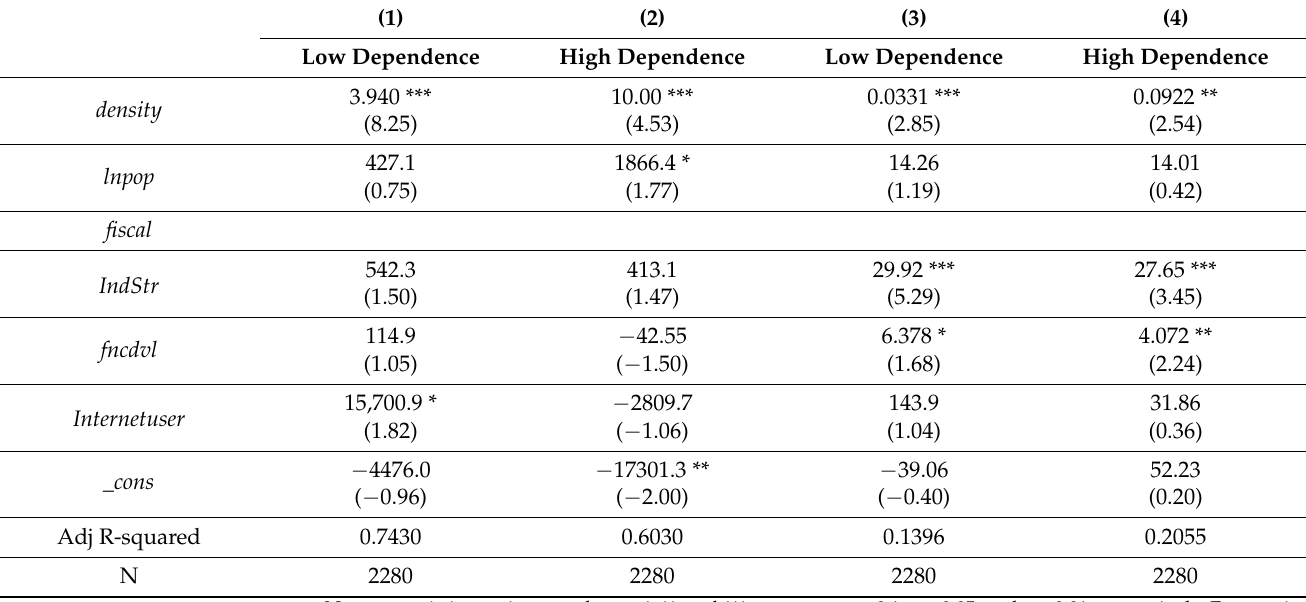
Table 6. Heterogeneous intermediary effects: impact of density on